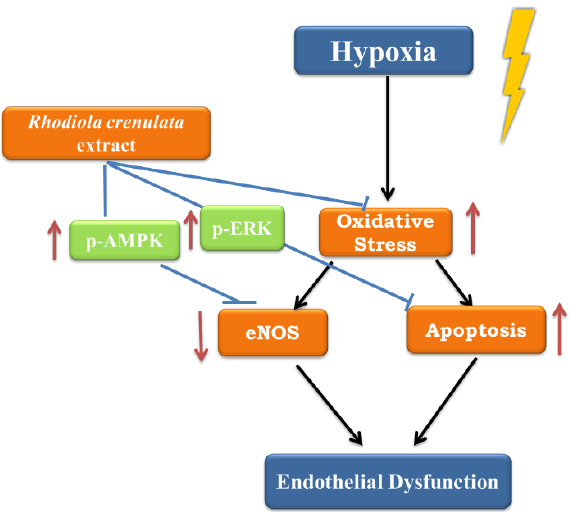
Figure 6. Proposed mechanisms of Rhodiola crenulata root extract on hypoxia-induced endothelial dysfunction. Arrows: increase; T-bar: attenuation; : hypoxic stimulation.